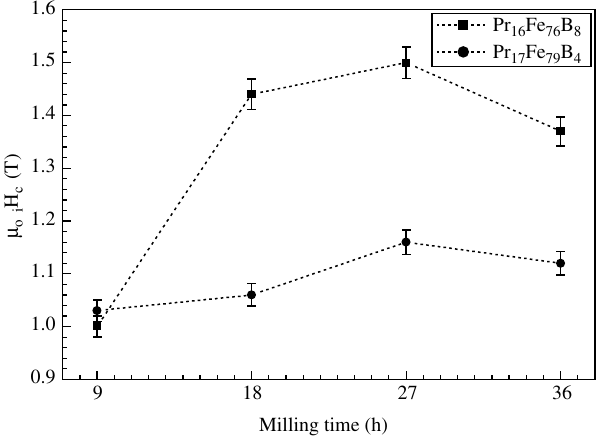
Figure 3. Intrinsic coercivity of Pr function of milling time.